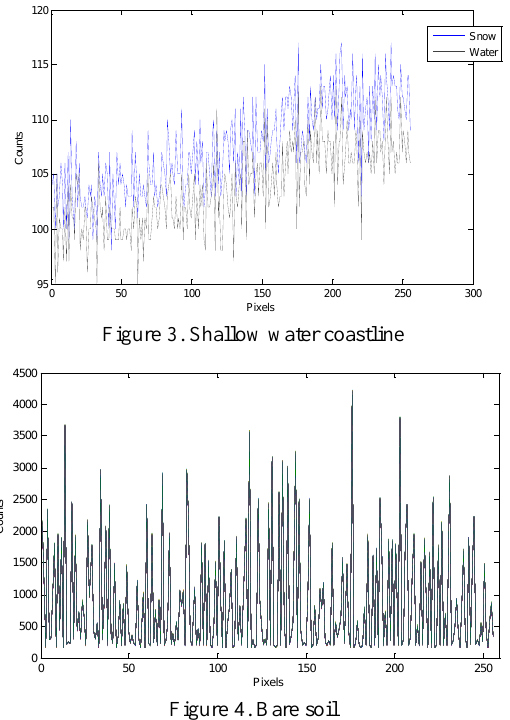
Figure 4. Bare soil